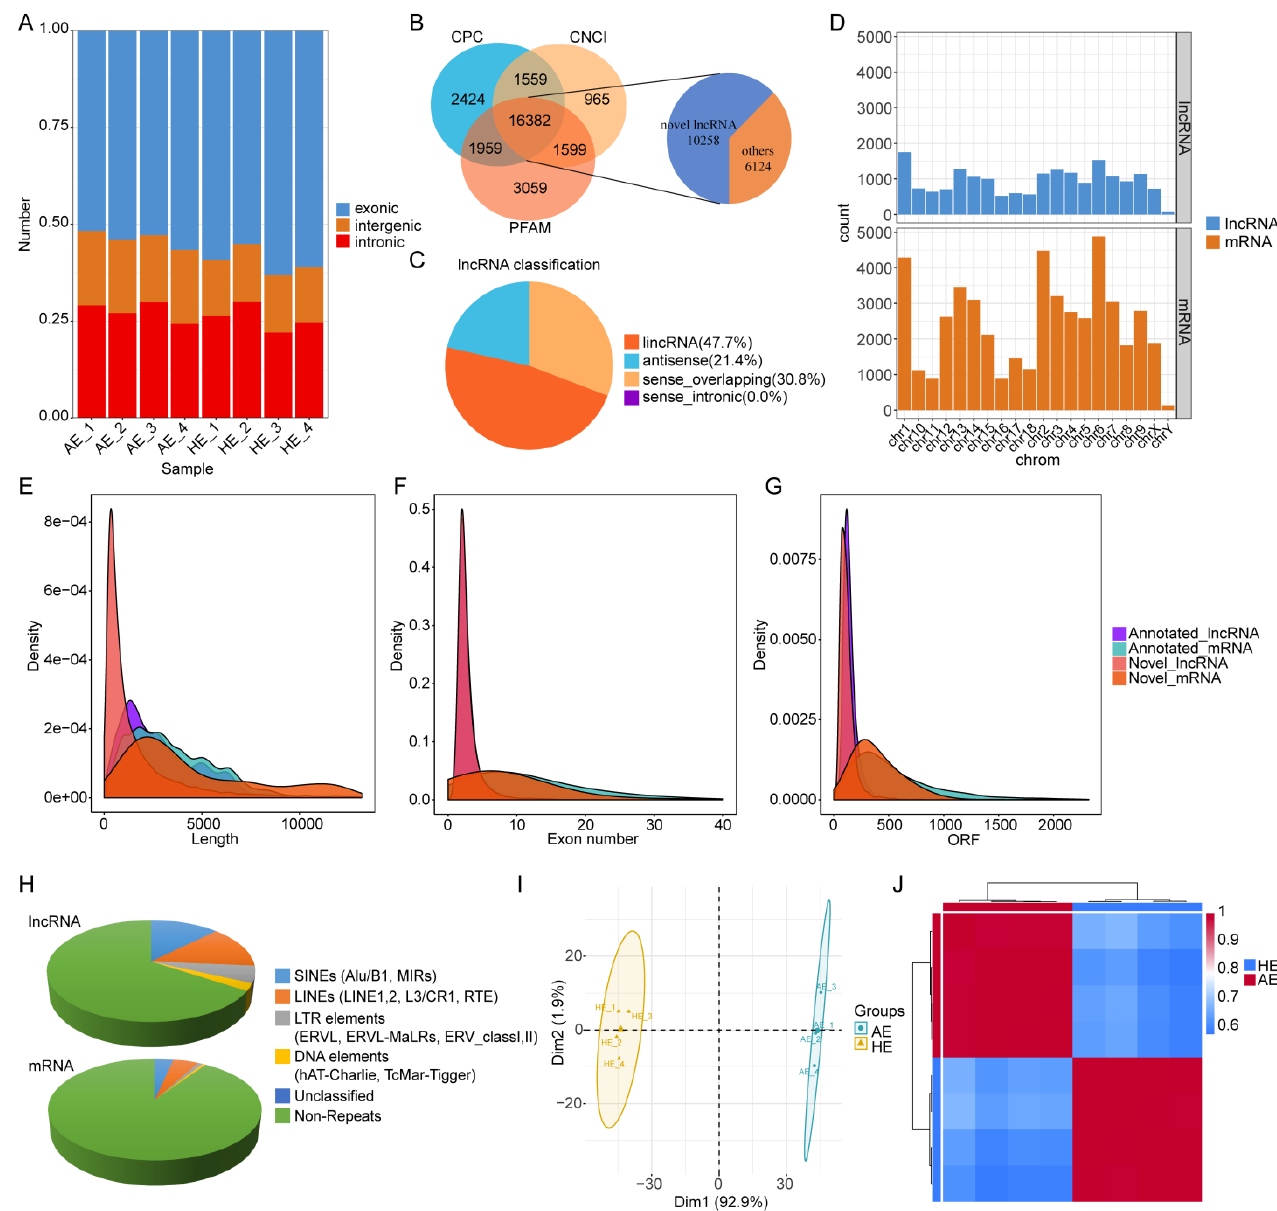
Figure 2. Identification and characterization of lncRNAs and mRNAs. ( A ) Distribution of the reads in different regions of the genome. ( B ) Screening of candidate novel lncRNAs. Three tools (CPC, CNCI, and PFAM) were used to analyze the coding potential of the lncRNAs, and the iterated lncRNAs were designated as candidate novel lncRNAs and used together with annotated lncRNAs for subsequent analysis. ( C ) Classification of the novel lncRNAs. ( D ) Distribution of lncRNAs and mRNAs in the genome. ( E – G ) Transcript length, exon number, and ORF length distribution of the lncRNAs and mRNAs. ( H ) Pie chart showing the percentage distribution of repeat sequences in the lncRNA and mRNA populations. ( I – J ) PCA and hierarchical clustering heatmap were used to check the differences between paired endometrial samples.